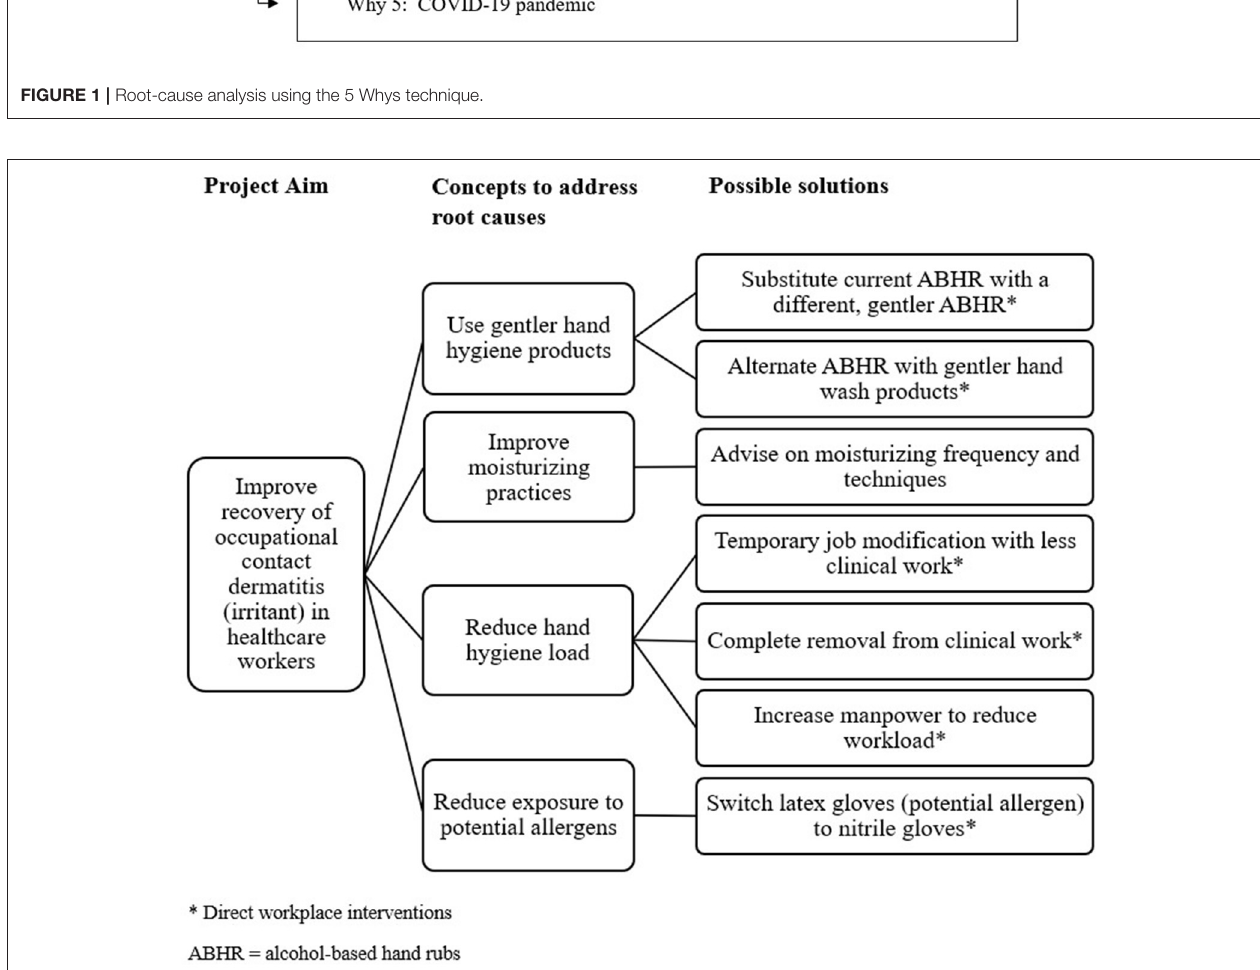
FIGURE 2 | Generating solutions with a tree diagram.